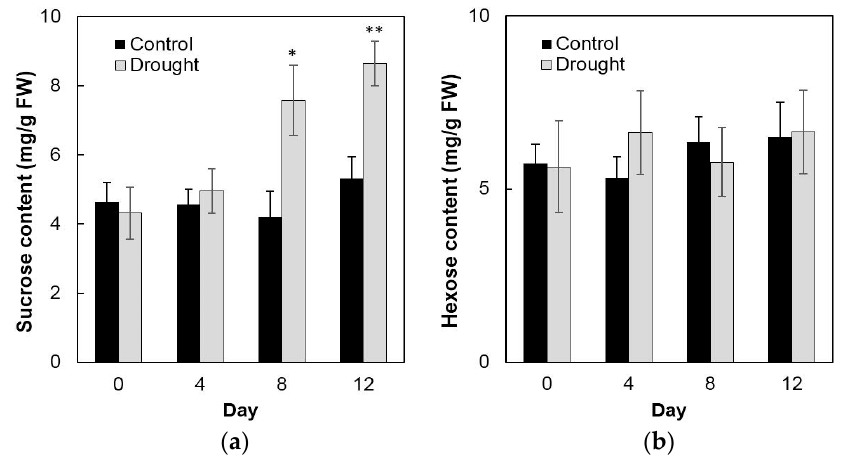
Figure 9. Effect of drought stress on sucrose content ( a ) and hexose content ( b ) in the maize sink part of the leaf. Data of sugar quantification represents mean ± SE of at least six biological replicates. Asterisks indicate significant differences in comparison with the control of 0 day by using a Student’s t -test: * p < 0.05, ** p < 0.01.